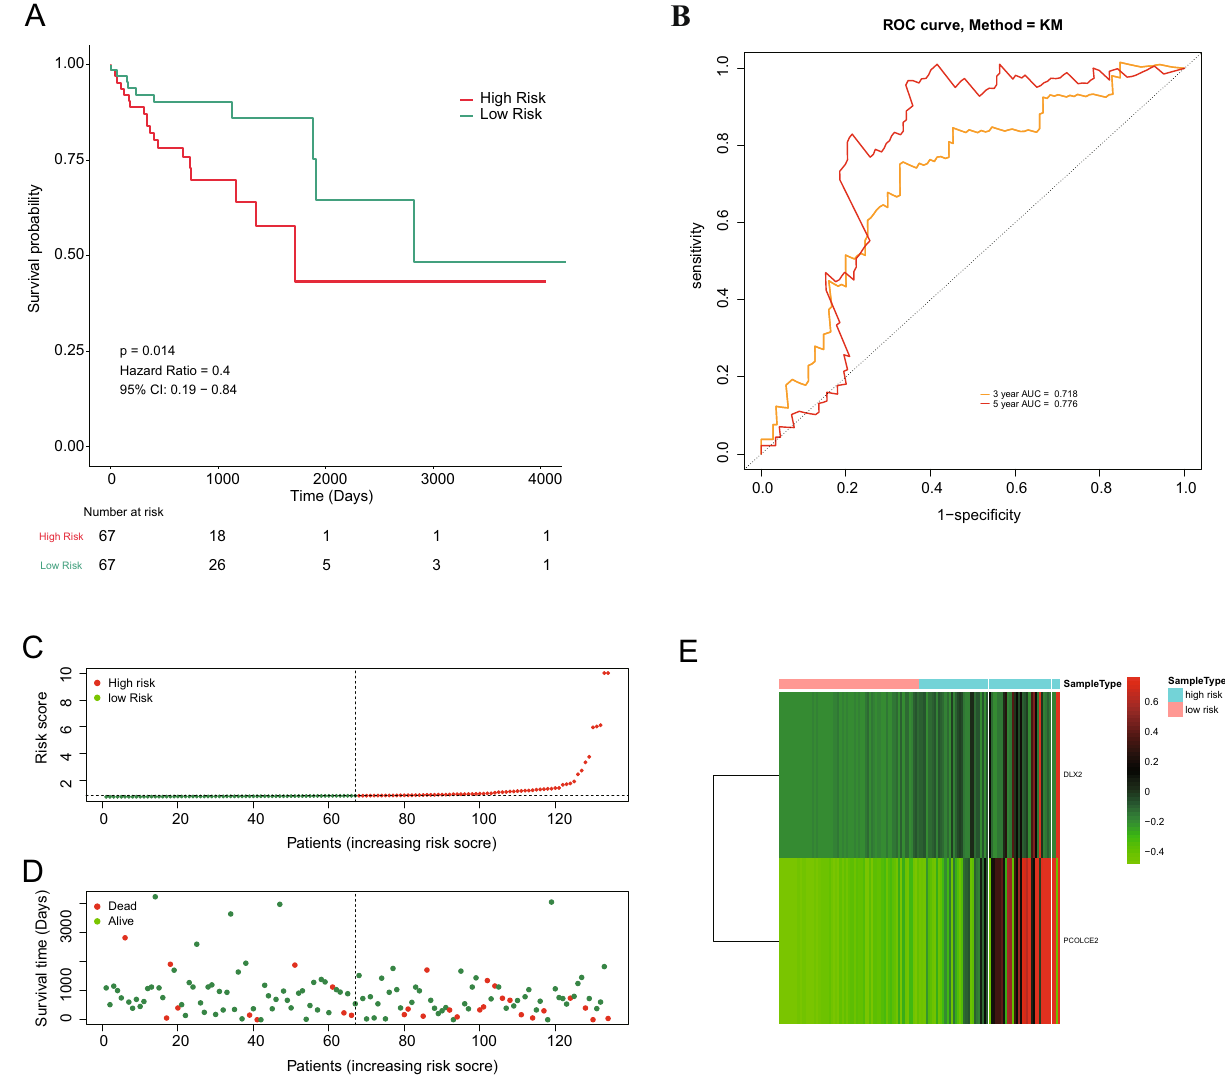
Figure 4. Validation of age related genes in CRC patients derived from TCGA dataset. ( A ) Kaplan–Meier survival curve of CRC patients between the low-risk group and the high-risk group. ( B ) 3- and 5-year ROC curve. ( C , D ) Risk score and survival status of the high-risk and low-risk groups. ( E ) The heat map of expression profile of the 2 prognostic genes. (software: pheatmap package in R, version number: 0.7.7, RUL link: https:// cran.r- proje ct. org/ src/ contr ib/ Archi ve/ pheat